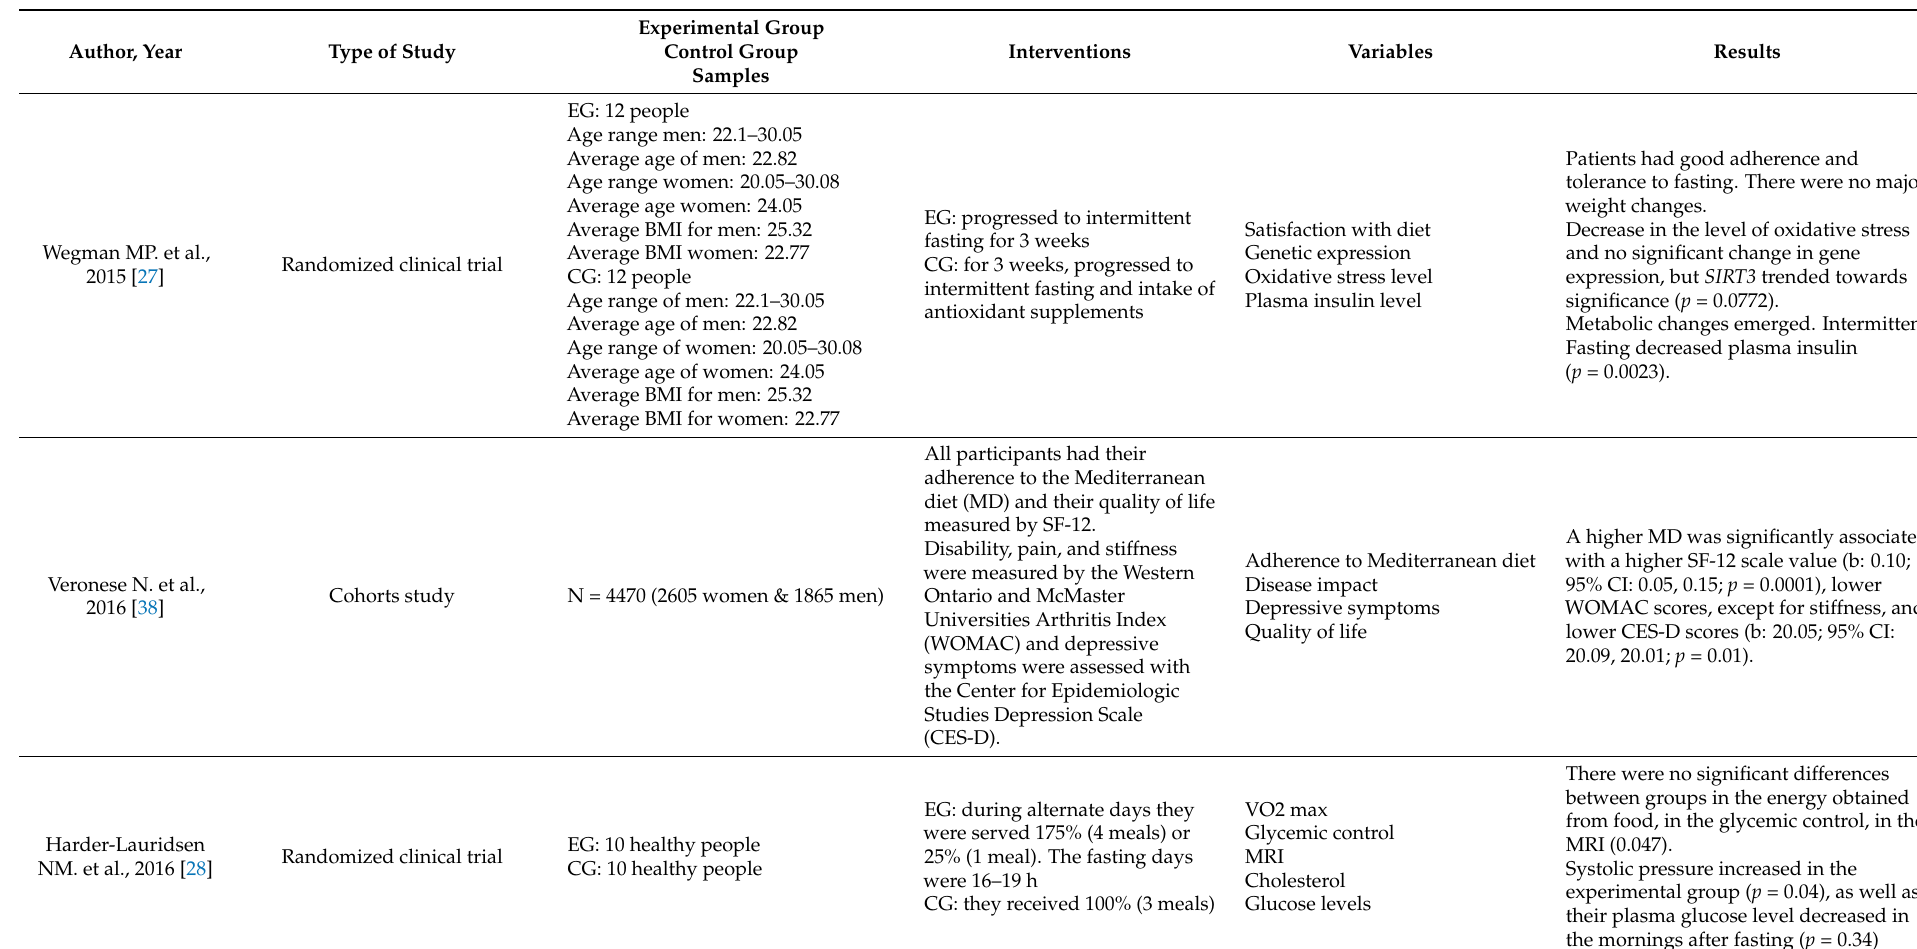
Table 5. Development of the general characteristics of the selected